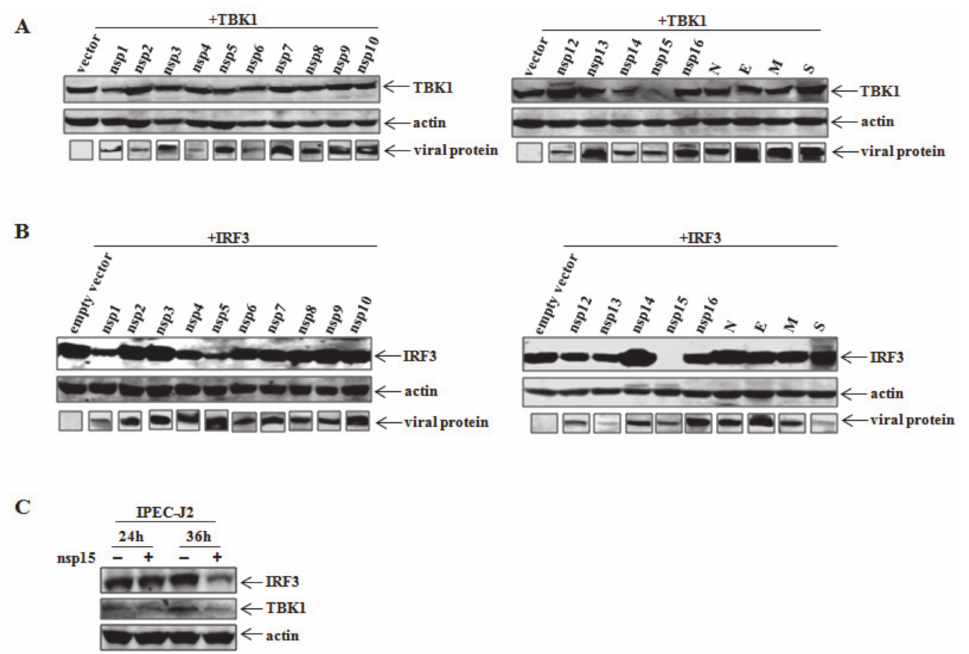
Figure 2. PEDV nsp15 reduces TBK1 and IRF3 expression at 36 h post transfection. ( A ) HEK293T cells were grown in 12-well plates and co-transfected with individual PEDV encoded protein (Flag tagged) and TBK1 (HA tagged). At 36 h posttransfection, cells were collected and determined by using anti-flag and HA antibodies. ( B ) HEK293T cells were seeded in 12-well plates followed by co-transfection with PEDV viral protein (Flag tagged) and IRF3 (HA tagged). At 36 h posttransfection, cells were subjected to western blot analysis with anti-flag and HA antibodies, respectively. ( C ) Cells were transfected with PEDV nsp15 (Flag tagged) for indicated culture, and then endogenous levels of TBK1 and IRF3 were determined by western blot using specific TBK1 or IRF3